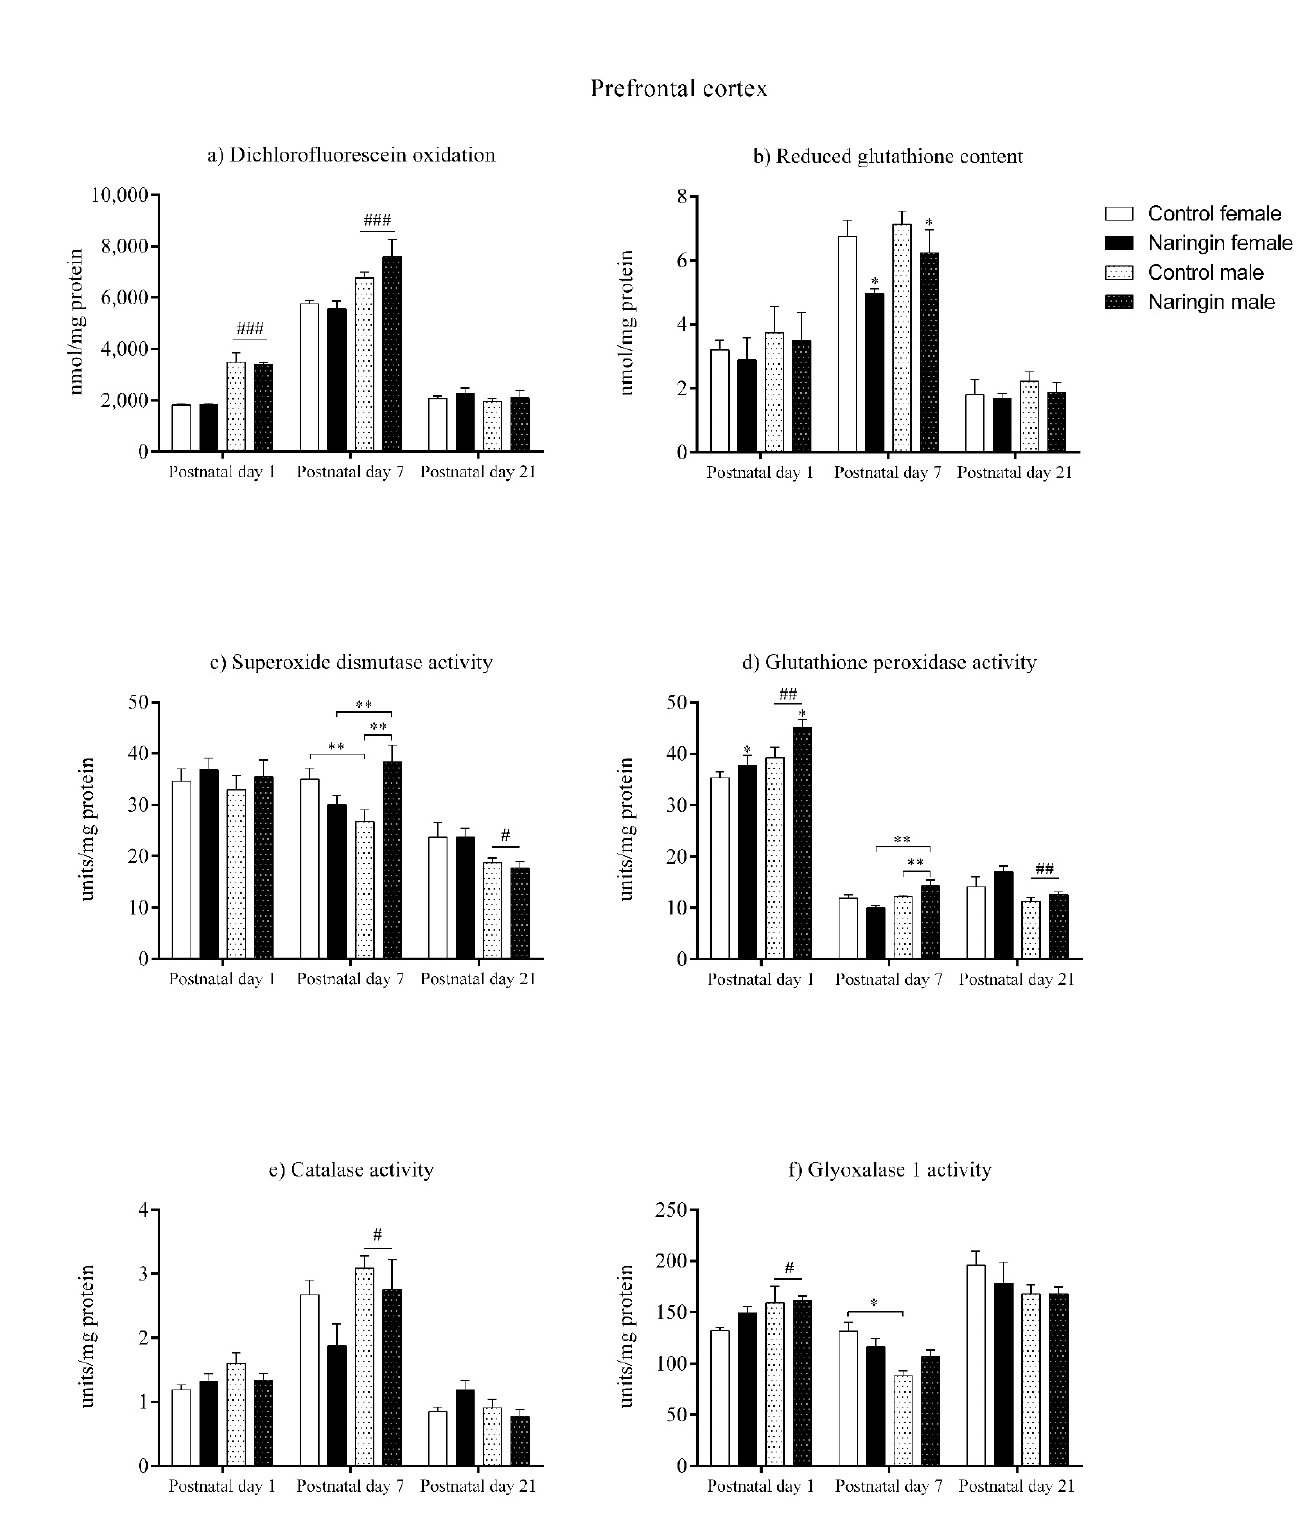
Figure 1. Effects of maternal naringin supplementation during the third week of gestation on the ( a ) dichlorofluorescein oxidation, ( b ) reduced glutathione content, ( c ) superoxide dismutase activity, ( d ) glutathione-peroxidase activity, ( e ) catalase activity, and ( f ) glyoxalase 1 activity in the offspring’s prefrontal cortex on postnatal days 1, 7, and 21. Results are expressed as mean ± S.E.M. Control female n = 8, naringin female n = 8, control male n = 8, naringin male n = 6. * p < 0.05; ** p < 0.01; # p < 0.05; ## p < 0.01, ### p < 0.001 (two-way ANOVA). Asterisks represent the main supplementation effect, and the hashes on bars represent the main sex effect. The asterisks on bars (single bracket) represent the significant comparisons by Sidak’s post-hoc test when interactions occurred.